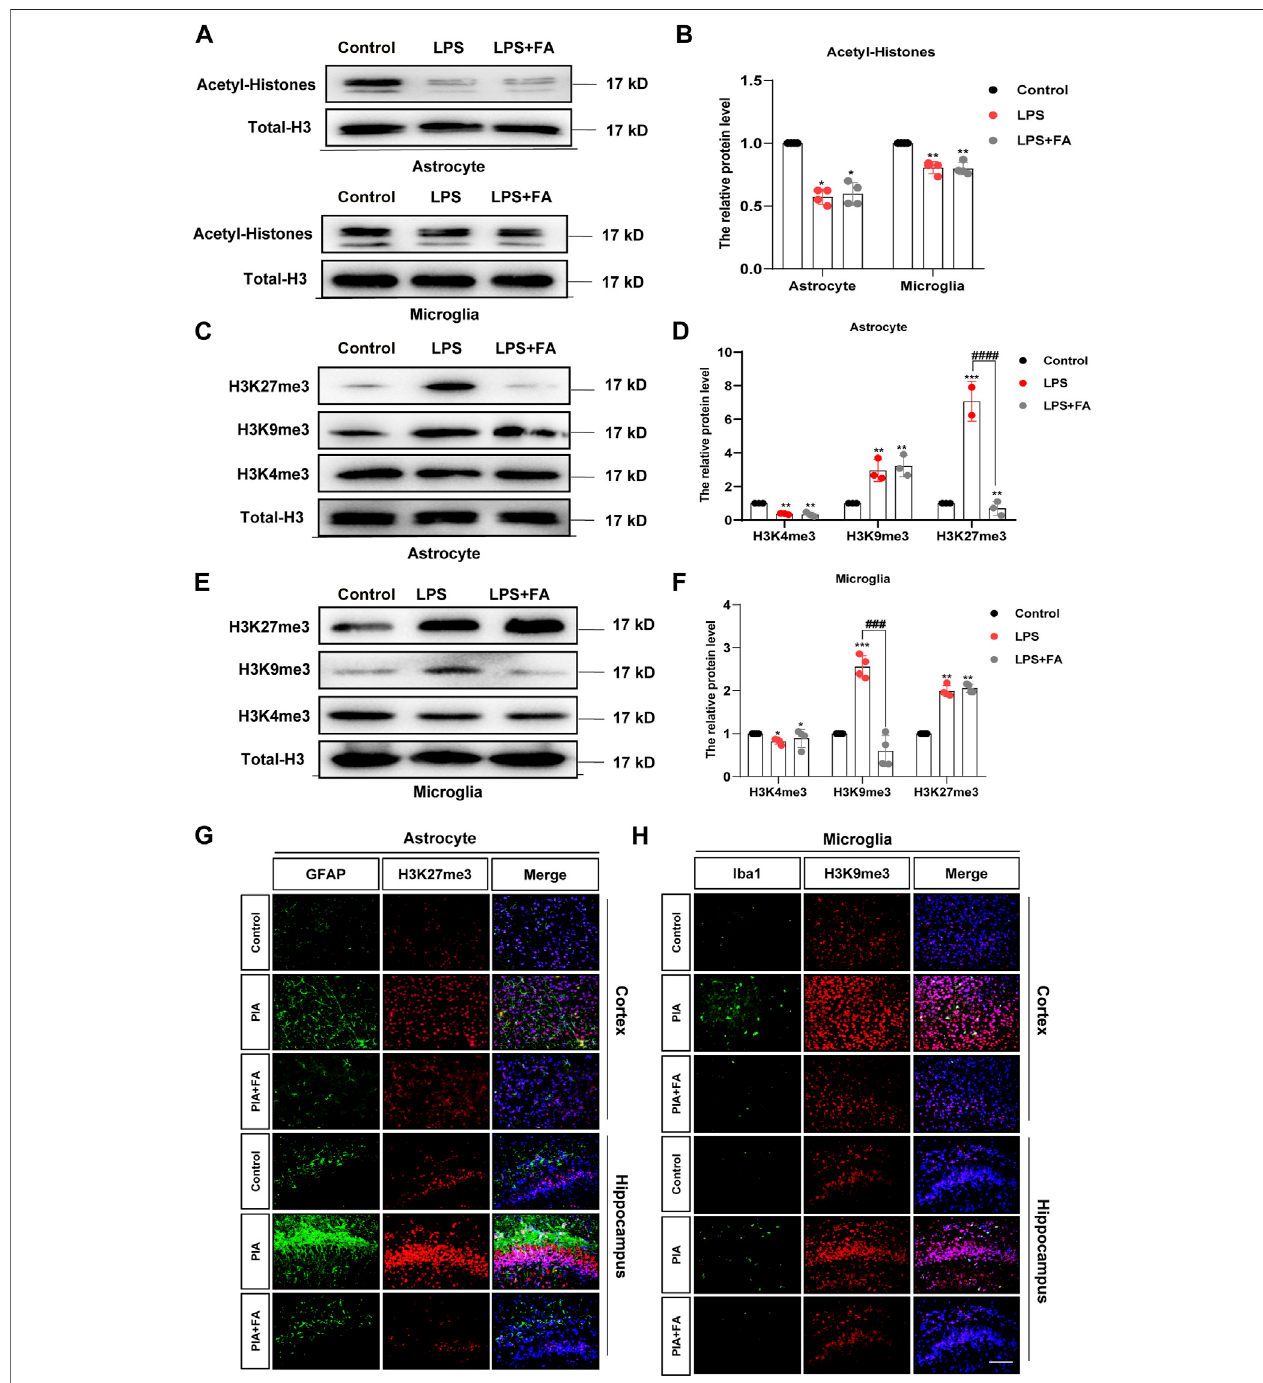
FIGURE 6 | FA regulated astrocyte and microglia activation through H3K27me3 and H3K9me3, respectively (A,B) Western blotting analysis of acetyl-H3 protein levelsintheprimaryastrocytesandmicroglia.FAhad noeffect ontheacetyl-H3 levels. (C,D) WesternblottinganalysisofH3K27me3, H3K9me3, andH3K4me3 protein levelsintheprimary astrocytes. FAonly affectedtheprotein levelsofH3K27me3. (E,F) Western blottinganalysisofH3K27me3,H3K9me3, and H3K4me3proteinlevels in the primary microglia. FA only affected the protein levels of H3K9me3. (G) Cortex and hippocampus sections were stained with GFAP (green) and H3K27me3 (red). Nuclei were stained with DAPI (blue). Increased H3K27me3 and GFAP intensity by PIA induction was lowered with FA treatment. (H) Cortex and hippocampus sections were stained for Iba1 (green) and H3K9me3 (red). Nuclei were stained with DAPI (blue). Increased Iba1 and H3K9me3 intensity by PIA induction was lowered with FA treatment (scale bar: 20 μ m). Data: mean ± SEM; * p < 0.05, ** p < 0.01, *** p < 0.001 versus the control group; ## p < 0.01, #### p < 0.0001 versus the PIA group; n = 4 per group (one-way ANOVA).